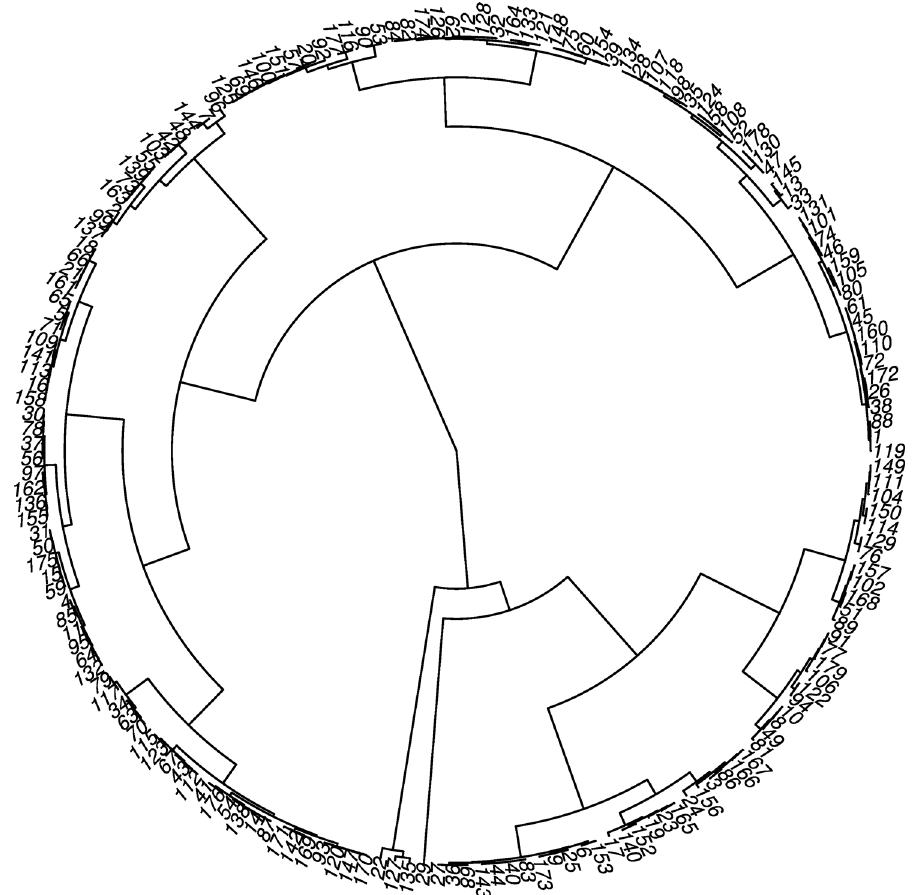
Fig 2. Ward cluster method based on the Mahalanobis distance, calculated using genotypic values estimated by the Bayesian multi-trait analysis.